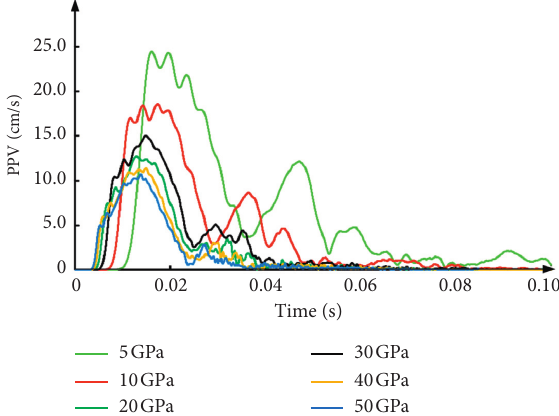
Figure 18: Changes of PPV of right wall with different dynamic modulus of elasticity versus time.